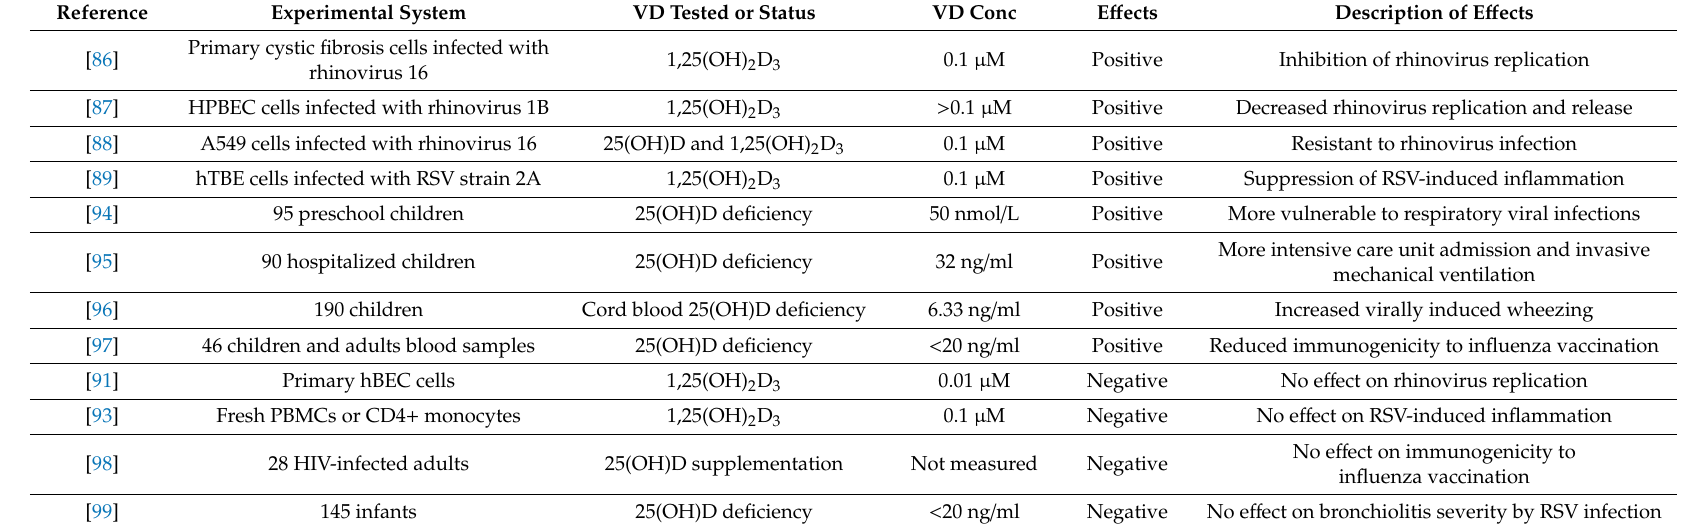
Table 2. E ff ects of VD on respiratory viral infection, pathogenesis, and treatment